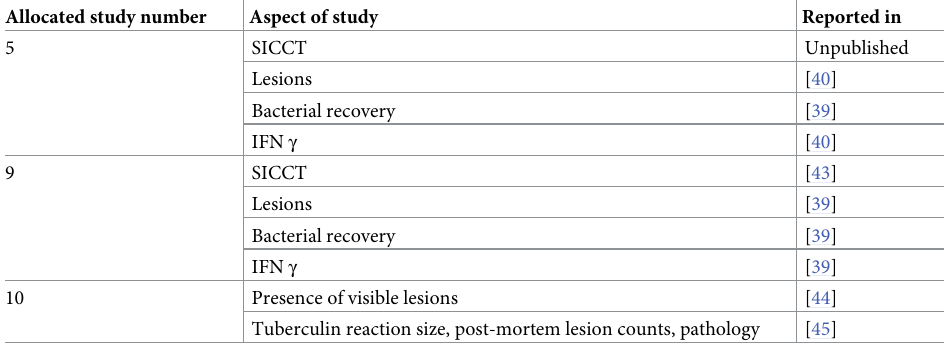
Table 2. A summary of where the outcomes from studies 5, 9 and 10 were